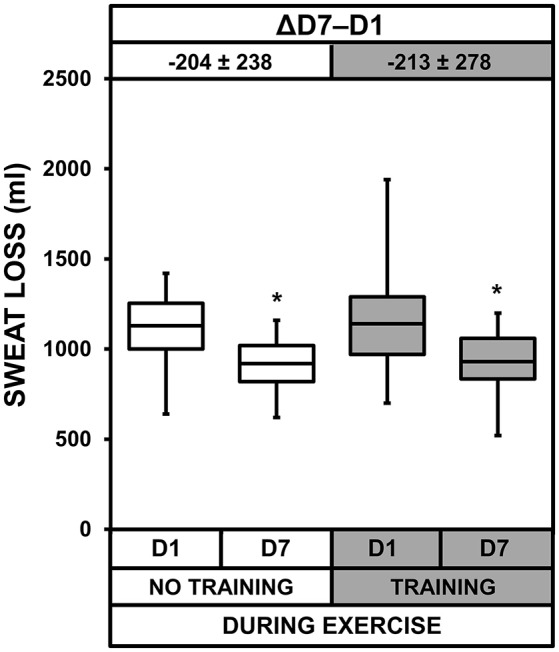
Box-and-whisker plots for sweat loss of the No Training and Training groups before (D1) and after (D7) heat acclimatization. The box encompasses the 25–75% quartiles, and the median is represented by the horizontal line within the box. The whiskers extend to the highest and lowest values. Values above the boxes, at the top of the plot, correspond to the differences (mean ± SD) between D7 and D1. Significantly different from D1, *p < 0.05.